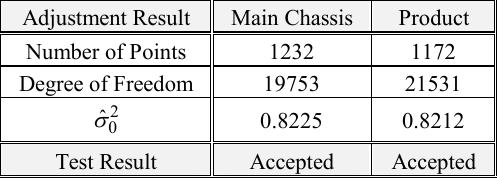
Table 3. Adjustment properties